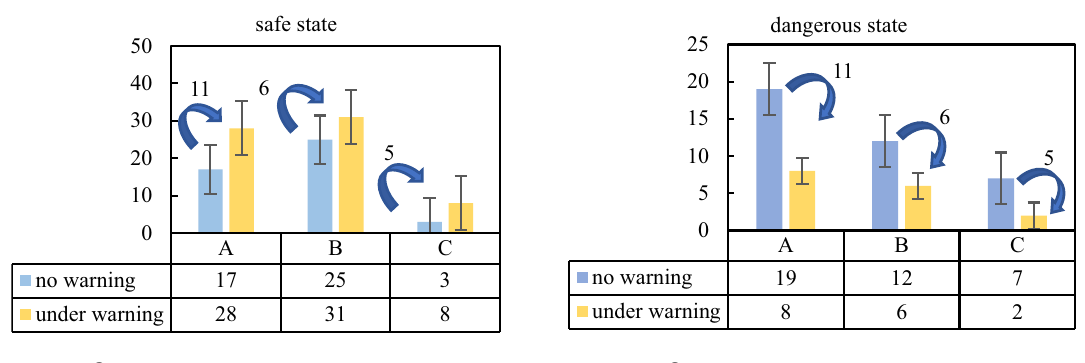
Figure 9. Distribution of the number of people in safe and dangerous state at 3